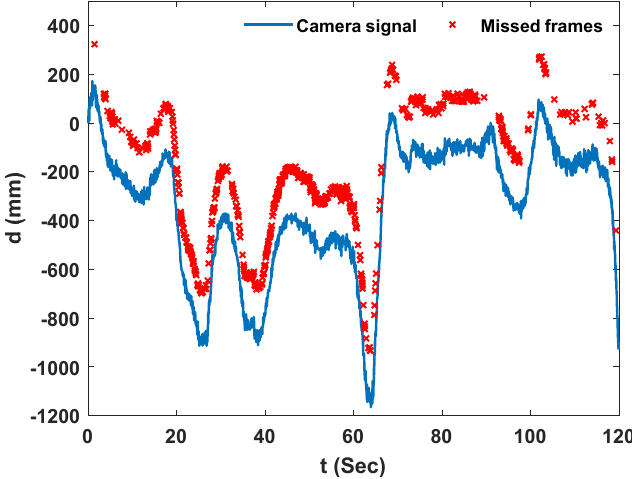
Figure 15. Camera signal in Y direction and the missed experiment frame, experiment 5.